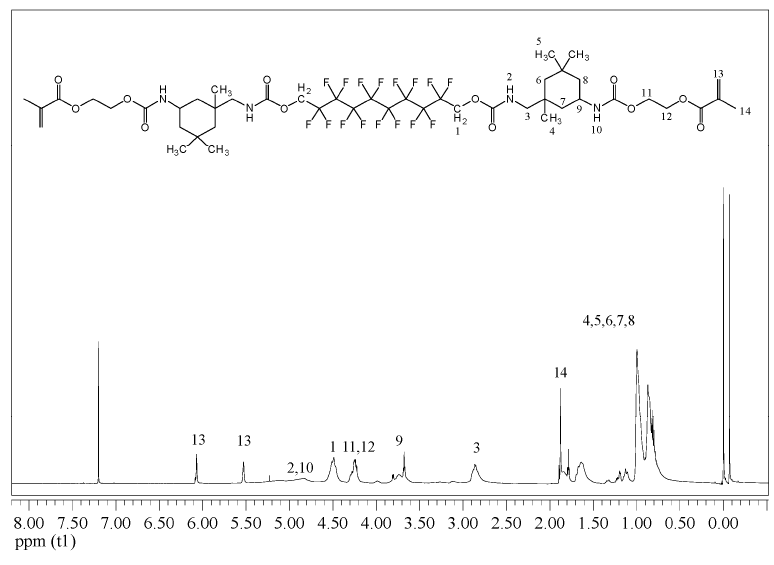
Figure 2. Fourier transform infrared spectroscopy (FT-IR) spectrum of fluorinated dimethacrylate (FDMA).